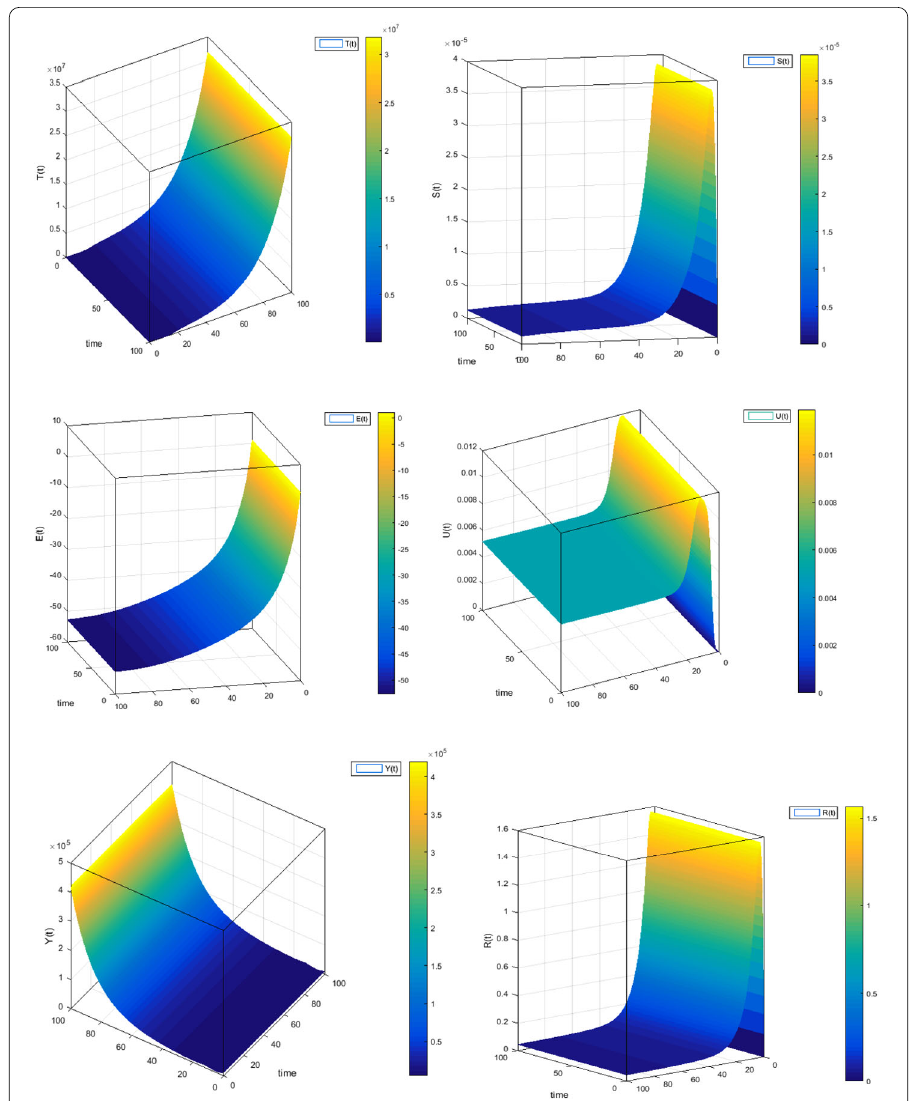
Figure 1 State variables simulations without controls at α = 0.96 using N2LIM